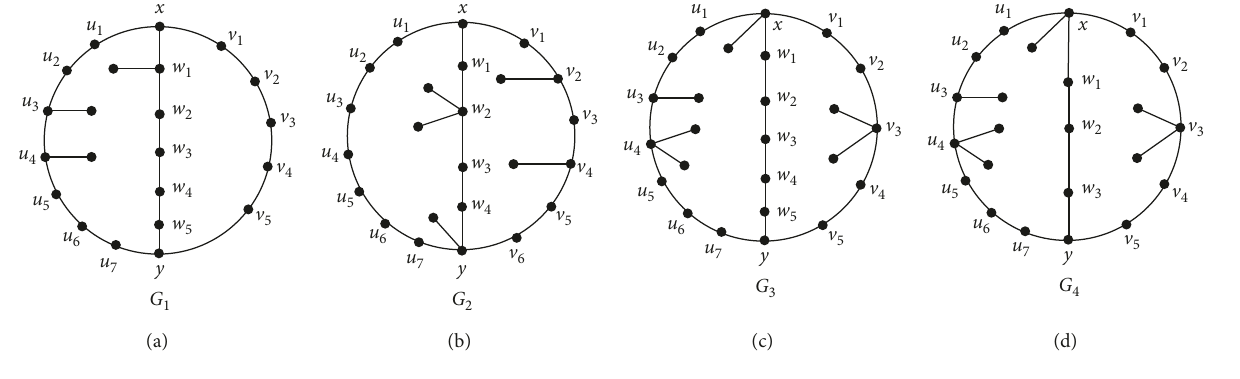
Figure 7: Graphs of Example